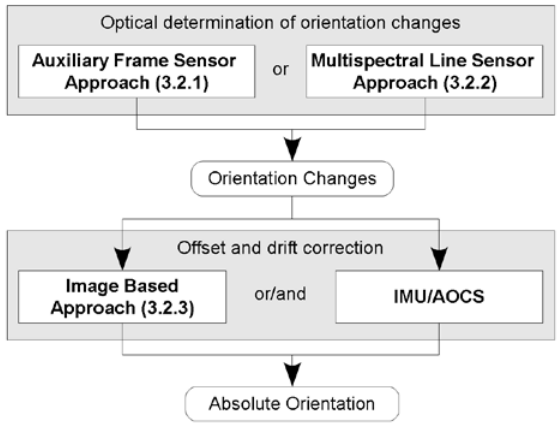
Figure 2: Options for optical determination of a